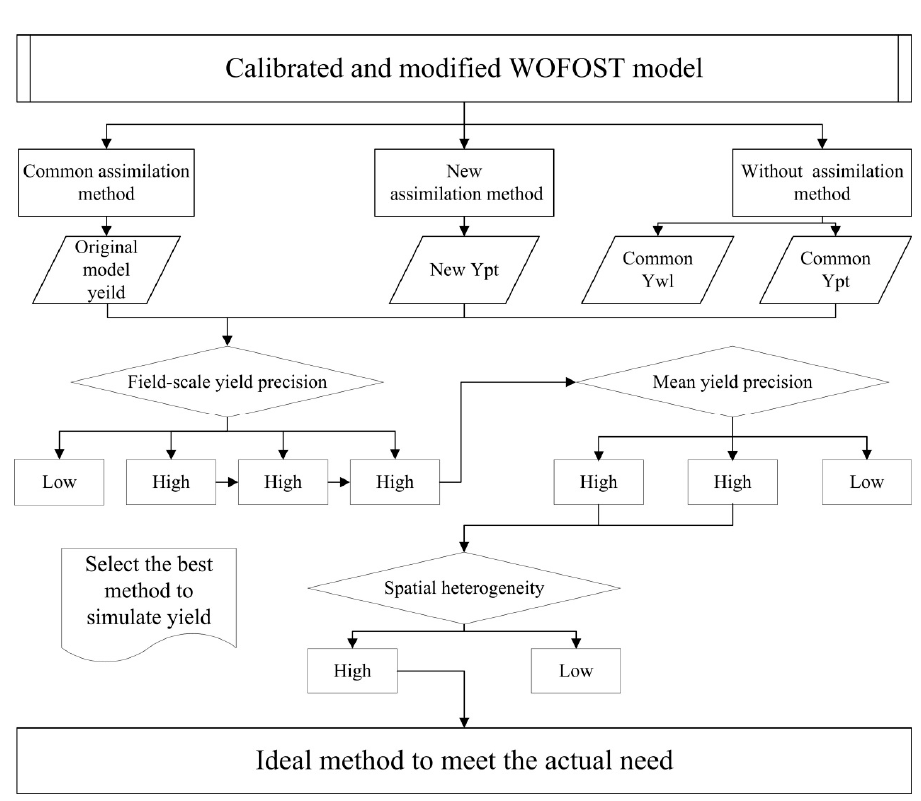
Figure 5. Reasons for selecting the new assimilation method.